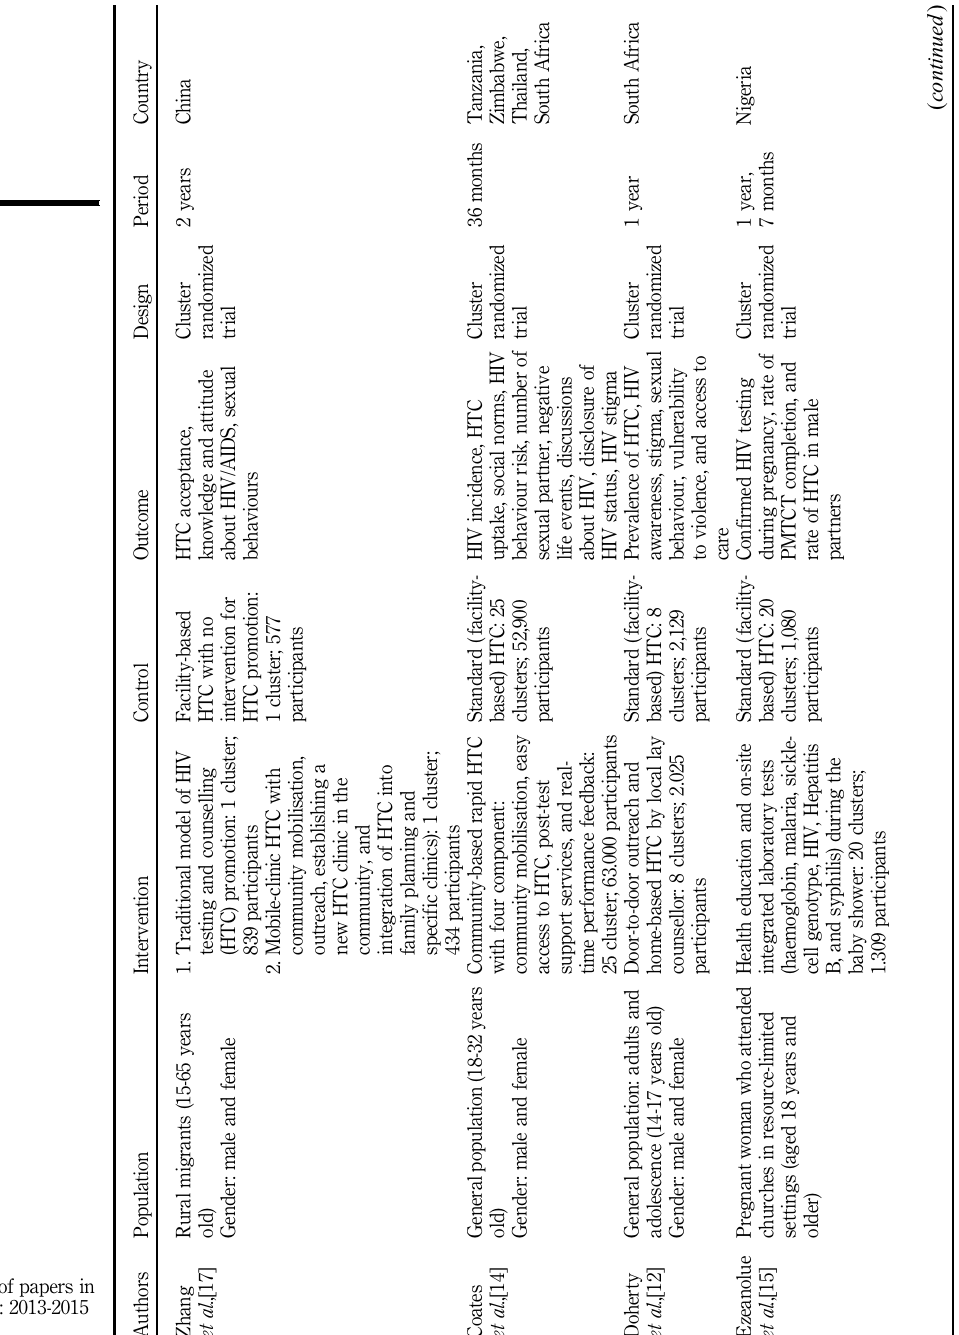
Table I. Overview of papers in the review: